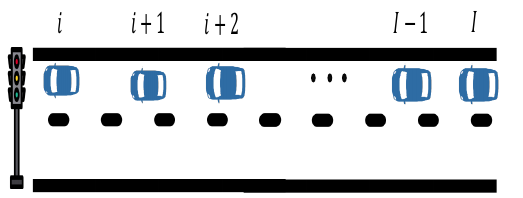
Figure 4. A set of vehicles on a signalised link, which may resemble a frame of video data.